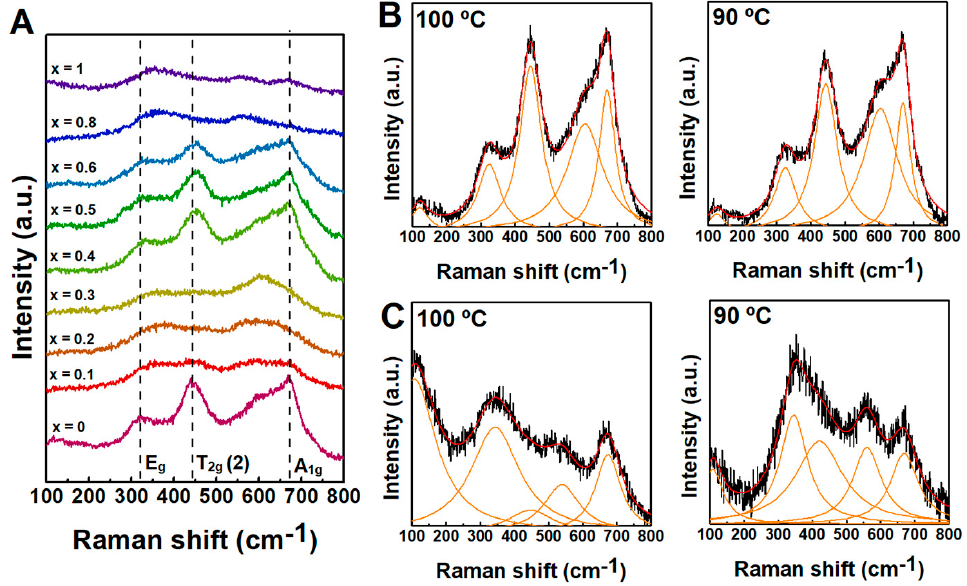
Figure 4. ( A ) A comparison of the Raman scattering spectra of the manganese- and/or calcium-doped ferrites obtained at 90 °C. The fitting of Lorentzian bands to Raman spectra of ( B ) manganese and ( C ) calcium ferrites synthesised at 90 °C and 100 °C.